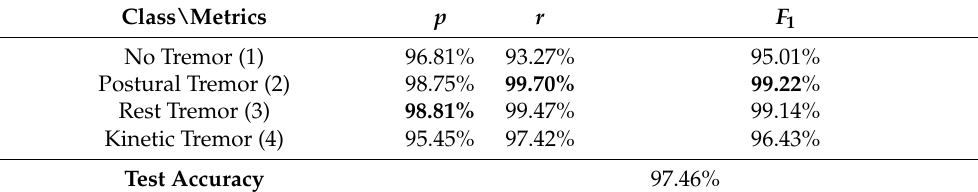
Table 5. Classification performance results computed on acceleration data only (considering all axis).